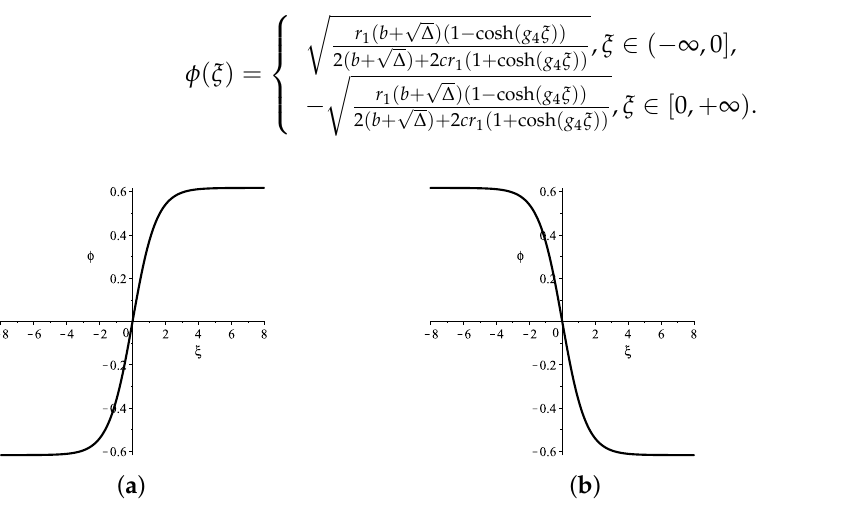
Figure 13. Kink and anti-kink wave forms of system (5). ( a ) Kink wave given by Equation (28). ( b ) Anti-kink wave given by Equation